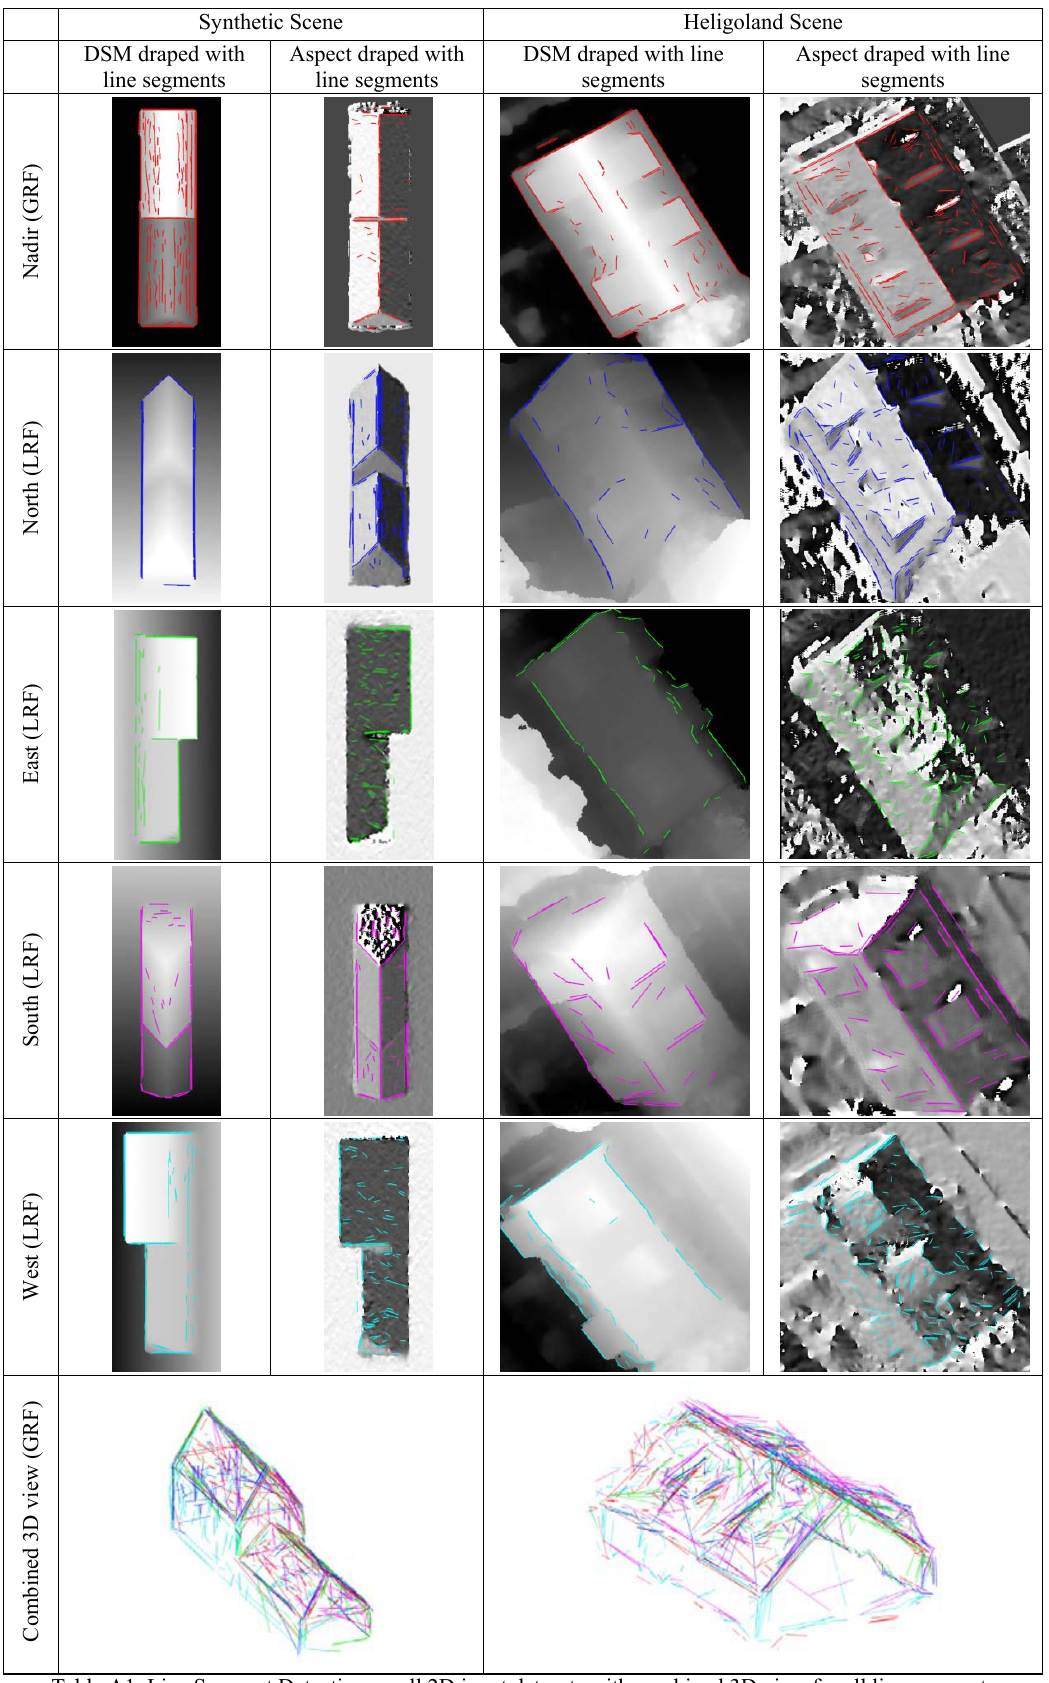
Table A1. Line Segment Detection on all 2D input datasets with combined 3D view for all line